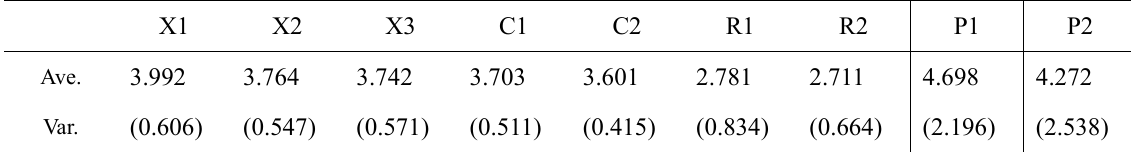
Table 2. Average and